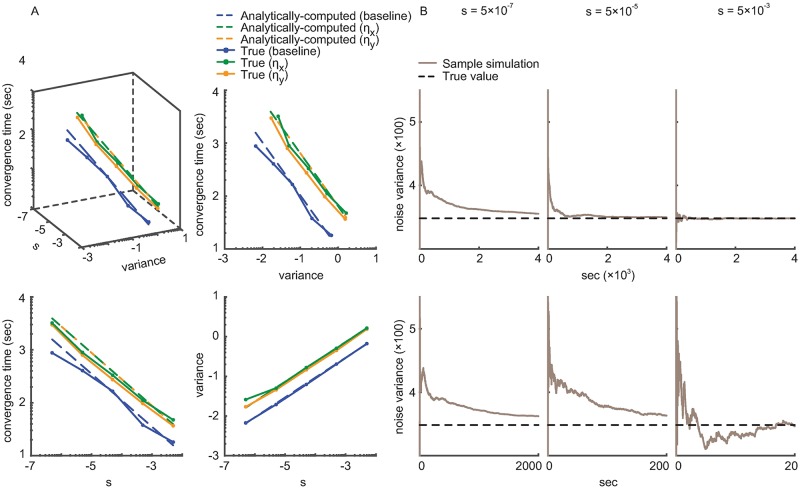
The calibration algorithm generalizes to training datasets with non-periodic state trajectories.Figure convention is the same as Fig 3. Here the true quantities are computed in closed-loop BMI simulations with a non-periodic trajectory generated by selecting targets randomly and uniformly. The analytically-computed error covariance and convergence times given by the calibration algorithm closely match their true values across a wide range of the learning rate s, showing that the calibration algorithm extends across training datasets with different state-evolution trajectories.